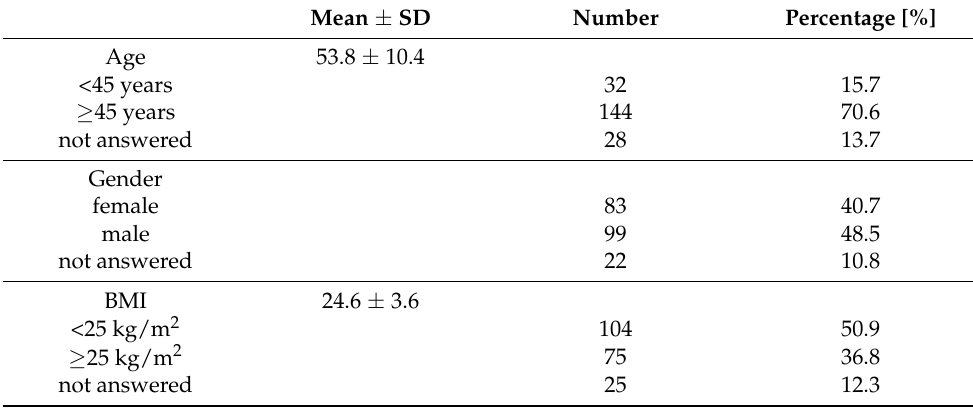
Table 1. General characteristics of participating